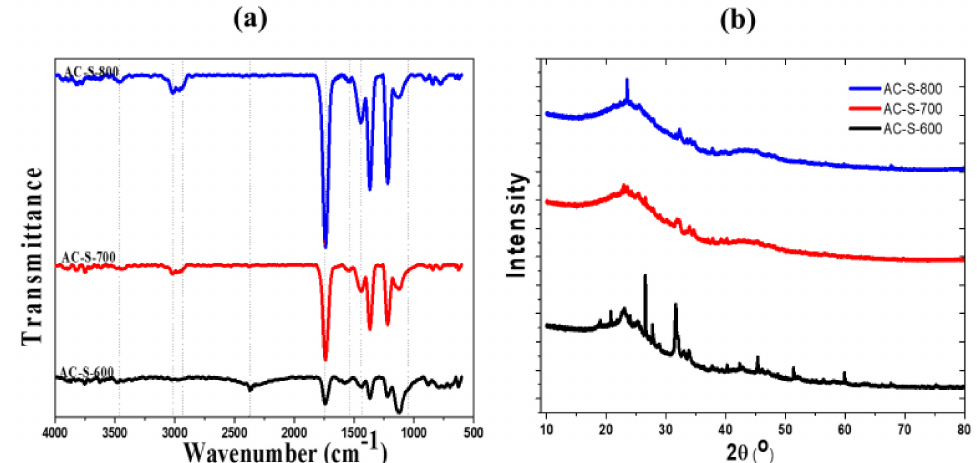
Figure 4. ( a ) Fourier transform infrared (FTIR) spectra and ( b ) X-ray di ff raction (XRD) peaks for AC-S-600, AC-S-700 and AC-S-800 AC